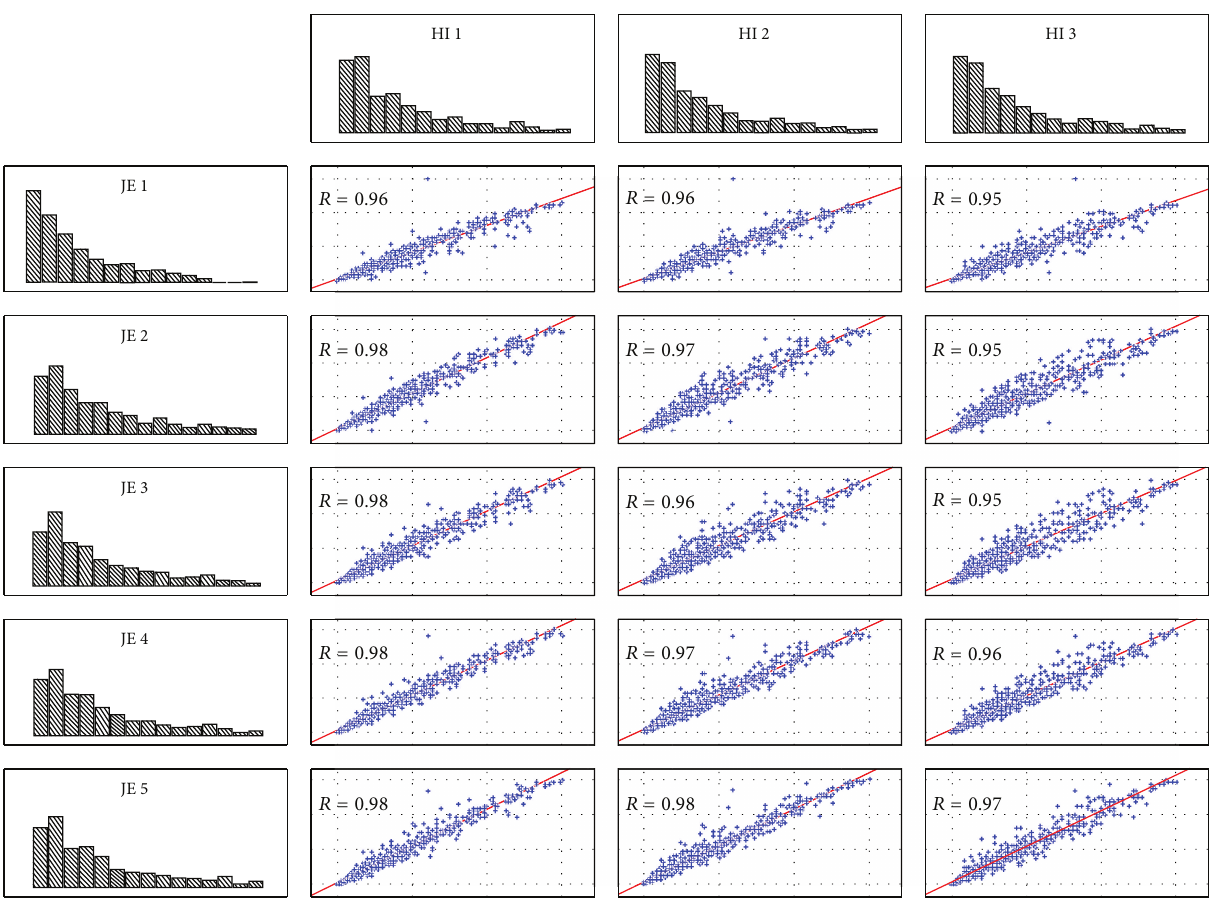
Figure 5: Graphic correlation matrix with linear regression coefficients 𝑅 for the daily energy yields at the coastal sites for the entire data period from the beginning of 2006 through the end of 2008. The frequency distributions are equally divided into 15 classes for all